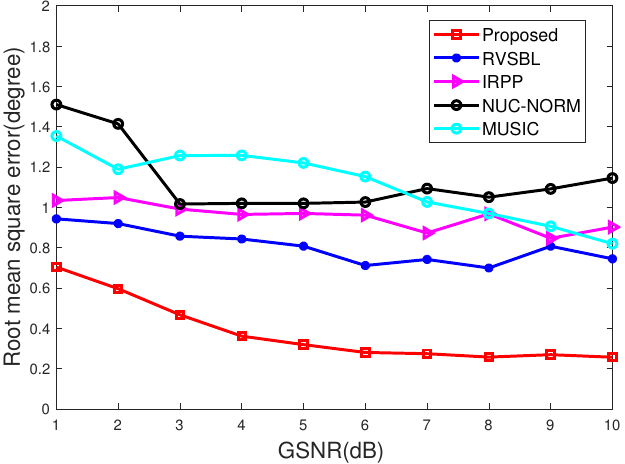
Figure 2. RMSE with different GSNRs.